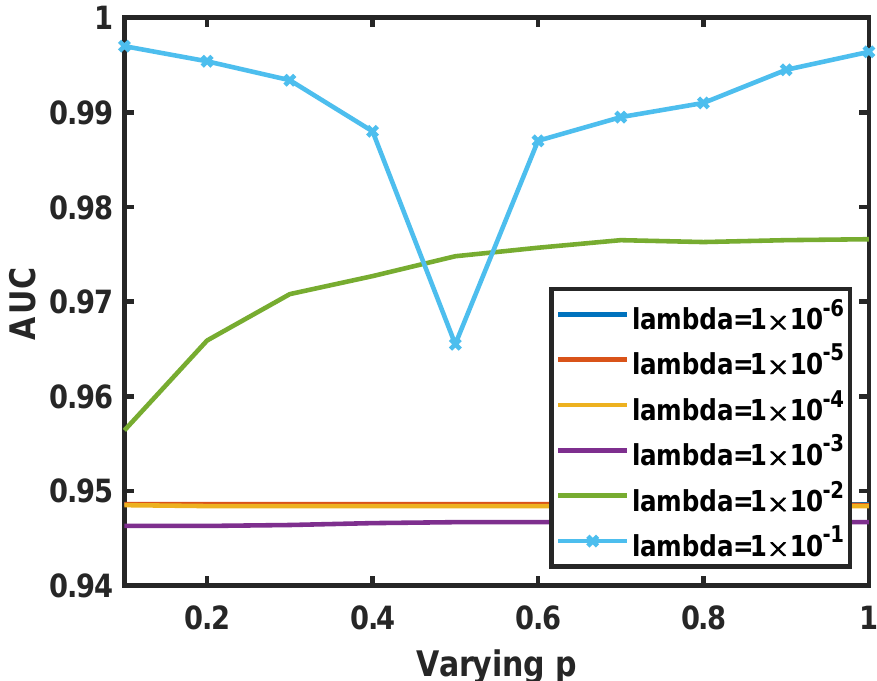
Figure 10. AUC values of different varying p , as well as lambda ( λ ), in the SpecTIR dataset.